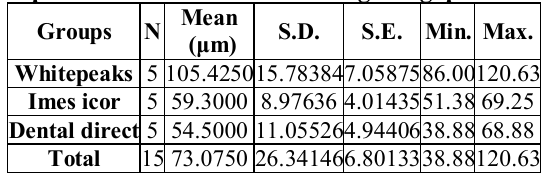
(table 2). One-way ANOVA for translucent crowns milling machine groups (white peaks, Imes-icor and dental direct). Table 2: One way- ANOVA for translucent crowns milling machine groups (whitepeaks, Imes icor and dental direct) Sum of Squaresdf Mean